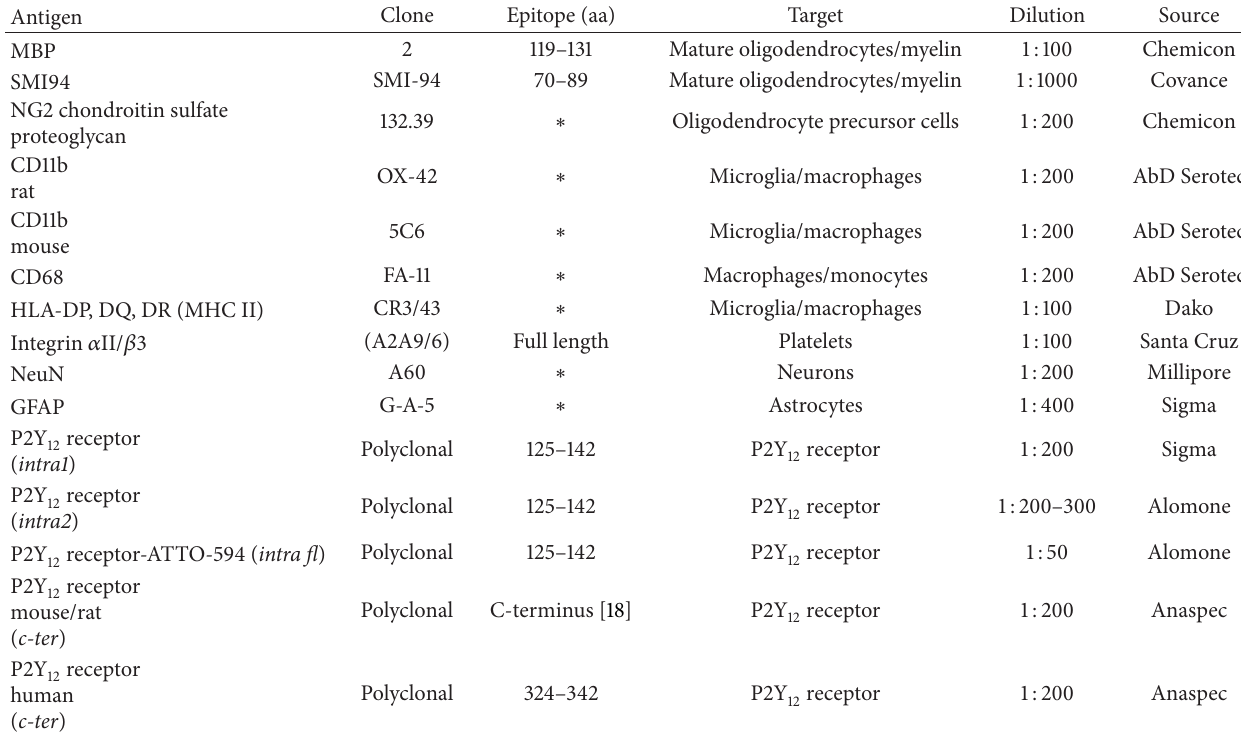
Table 1: Primary antibodies employed in the